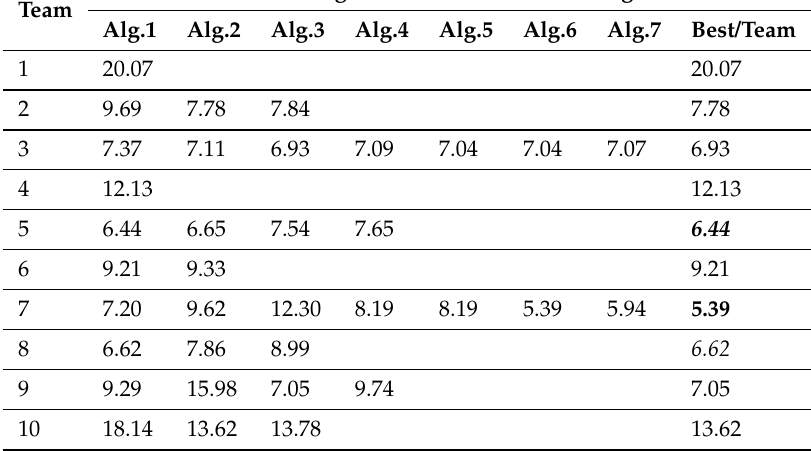
Table 7. Comparison of predicted errors as mean absolute error (year) for age estimation. Note that 8 out of 10 teams submitted multiple results using different algorithms (Alg.). ‘Best/team’ is the Best result for each team is considered. 1st position is highlighted as bold ; 2nd best result is shown as bold-italic ; and 3rd best result is marked by italic